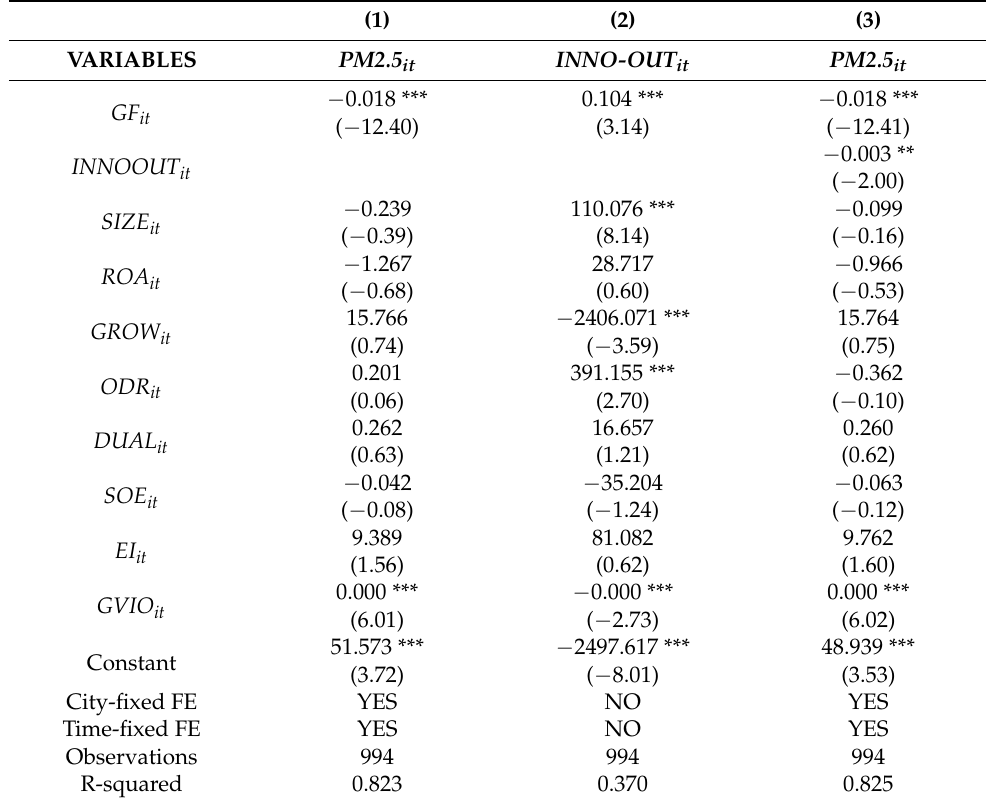
Table 8. Regression results after tail